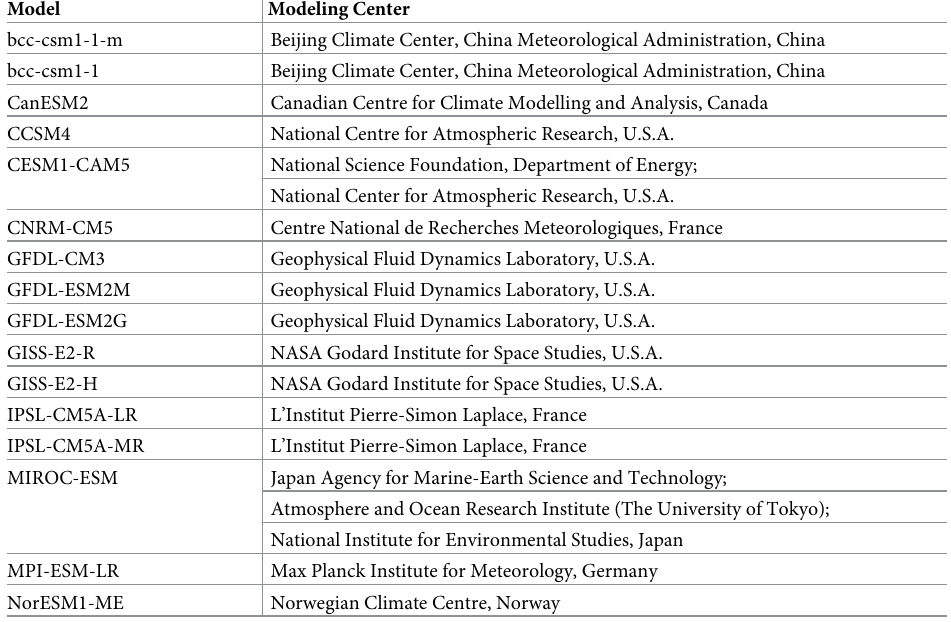
Table 3. Climate projection models.